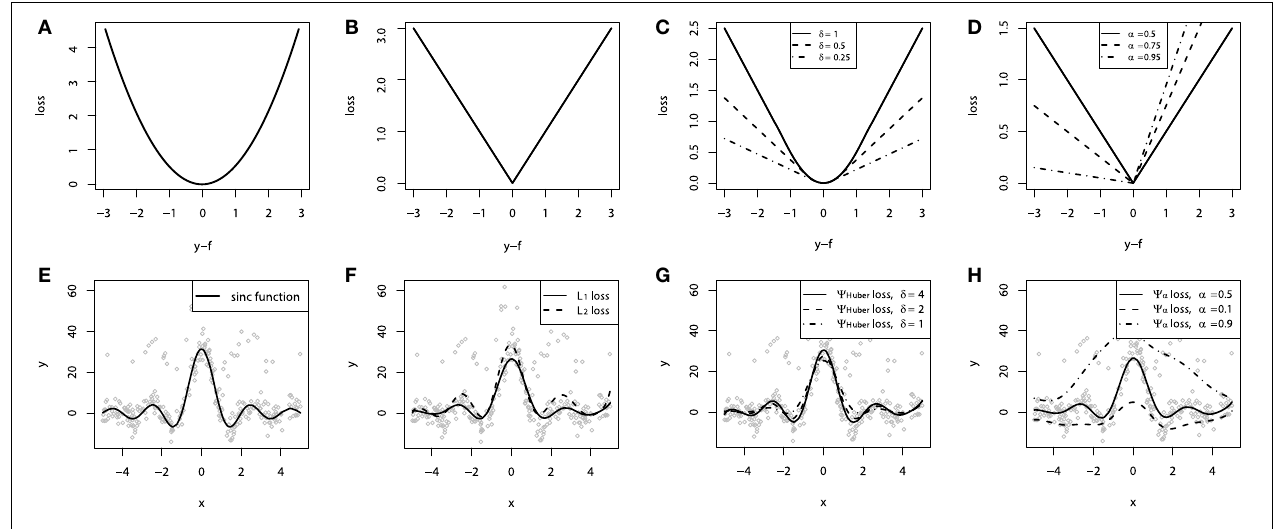
original sinc(x) function; (F) smooth GBM fitted with L 2 and L 1 loss; (G) smooth GBM fitted with Huber loss with δ = { 4 , 2 , 1 } ; (H) smooth GBM fitted with Quantile loss with α = { 0 . 5 , 0 . 1 , 0 . 9 }